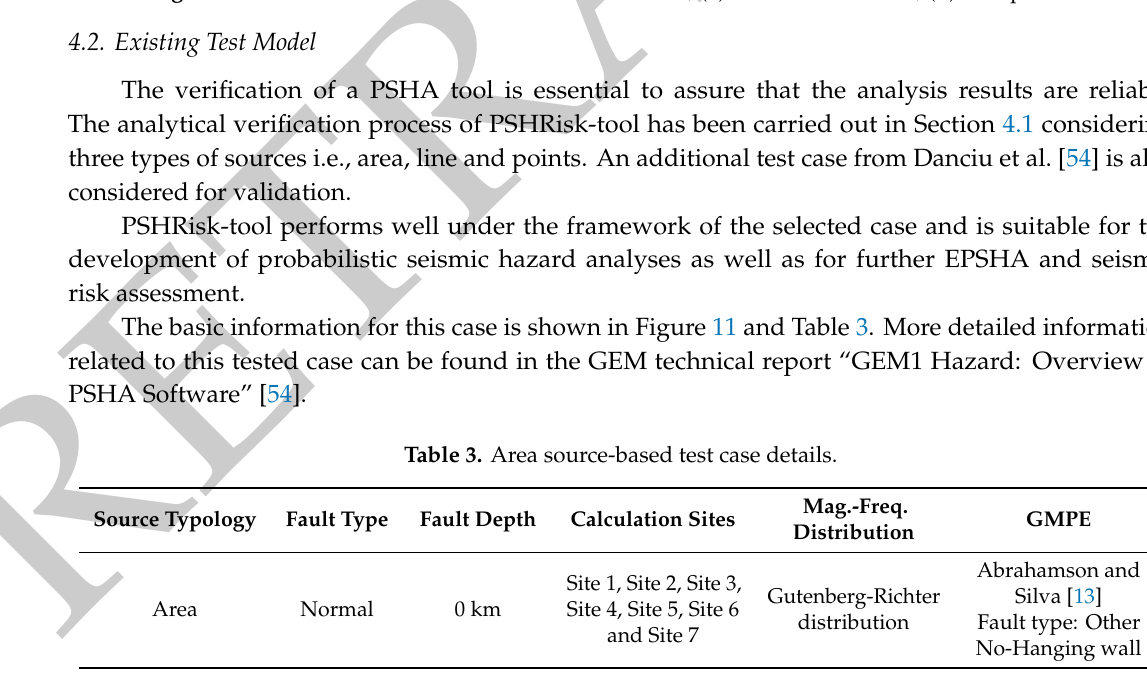
Figure 11. Area source-based test geometry and sites.